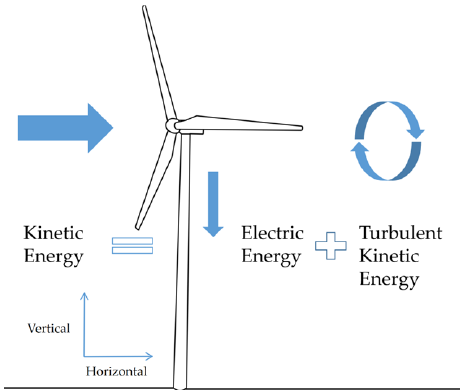
Figure 1. A brief diagram of the WFP scheme.